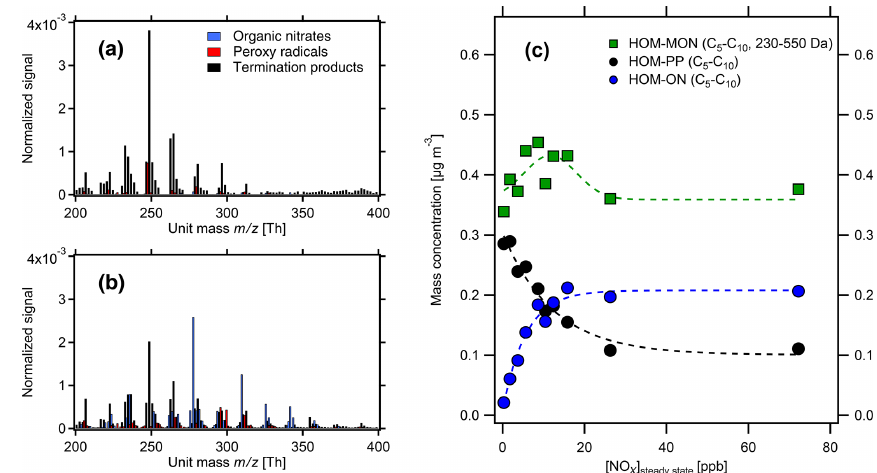
Figure 4. HOM pattern from α -pinene photooxidation at two NO x levels in the monomer range. (a) Low-NO x conditions ([ α -pinene] SS = 1 . 7ppb, [NO x ] SS = 0 . 3ppb); (b) high-NO x conditions ([ α -pinene] SS = 1 . 0ppb, [NO x ] SS = 8 . 7ppb). Black bars: HOM-PP termination products of Reactions R3 and R4a. Blue bars: HOM-ONs (organic nitrates). Red bars: HOM-RO 2 (peroxy radicals). The signals were normalized to the sum over all detected ions. (c) Mass concentrations of HOM monomers (green) in the molecular mass range 230–550Da. HOM-ONs (blue) are increasing with increasing [NO x ] SS , HOM-PPs (black) are decreasing, and the sum of all HOM monomers remains about the same. At about 10ppb [NO x ] SS HOM-ONs make up half of the HOM monomers, and at 26ppb [NO x ] SS they make up about 50% of the total HOMs (shown in Fig. 3). Dashed lines serve only to guide the eye.